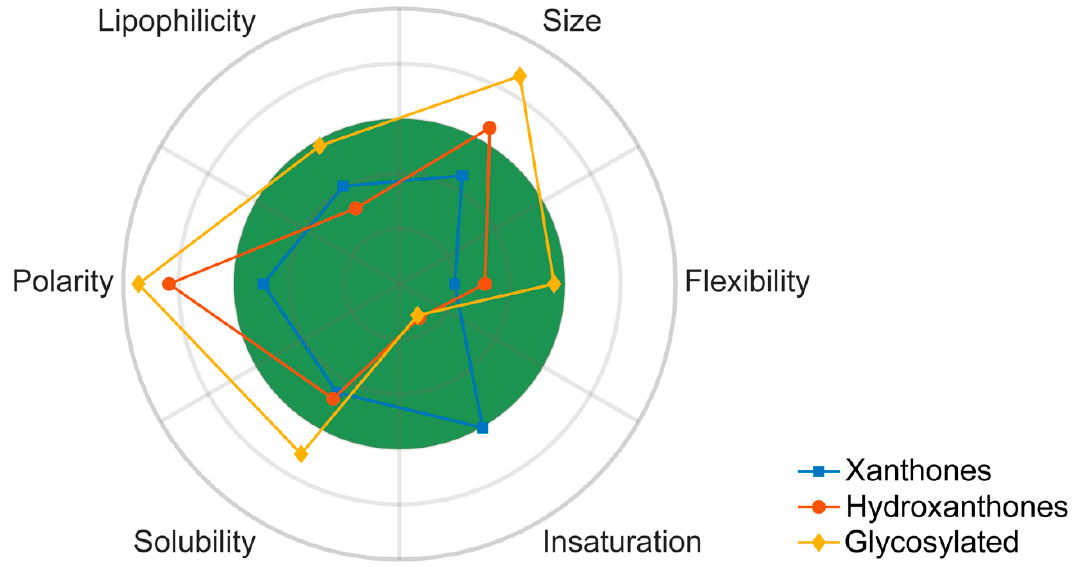
Figure 10. Polar plot of the marine xanthone chemical space. For each category, mean of RB (flexibility), mean of MW (size), mean of log P SILICOS-IT (lipophilicity), mean of PSA (Polarity), mean of log S SILICOS-IT (solubility), and mean Fsp 3 (unsaturation) plotted in polar coordinates. Green colored zone: 0 < RB < 9; 150 < MW < 500; 0 < log P < 5; 20 < PSA < 130; -5 < log S < 0; 1 > Fsp 3 > 0.25.